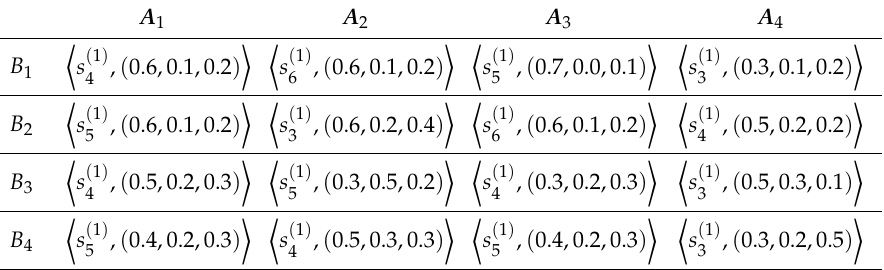
Table 2. Single-valued neutrosophic linguistic (SVNL) decision matrix R 1 .